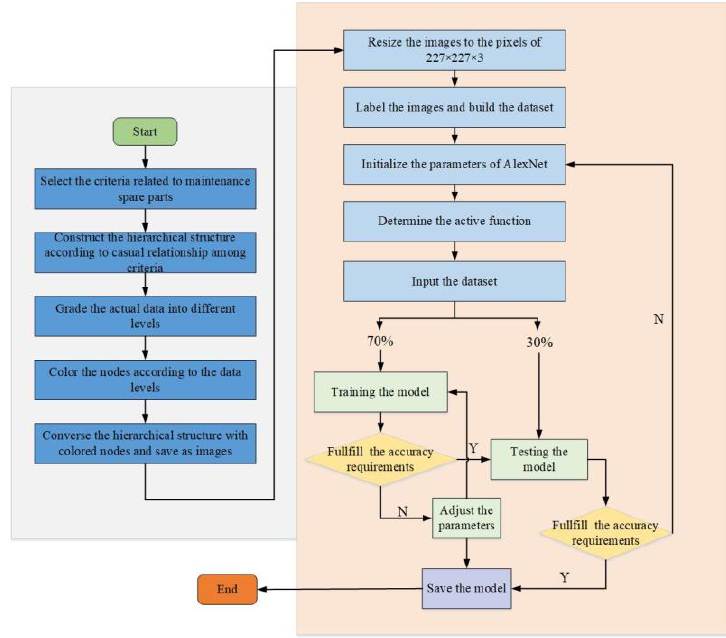
Figure 5. General process of the proposed approach.